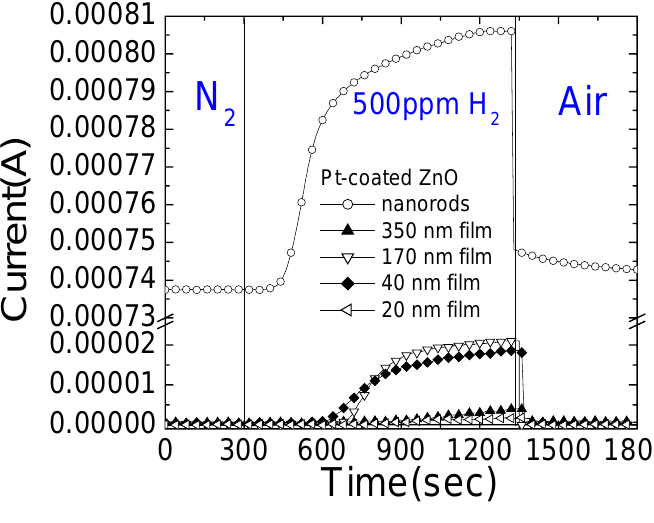
Figure 19. Time dependence of current from Pt-coated ZnO nanorods and thin films nanorods as the gas ambient is switched from N